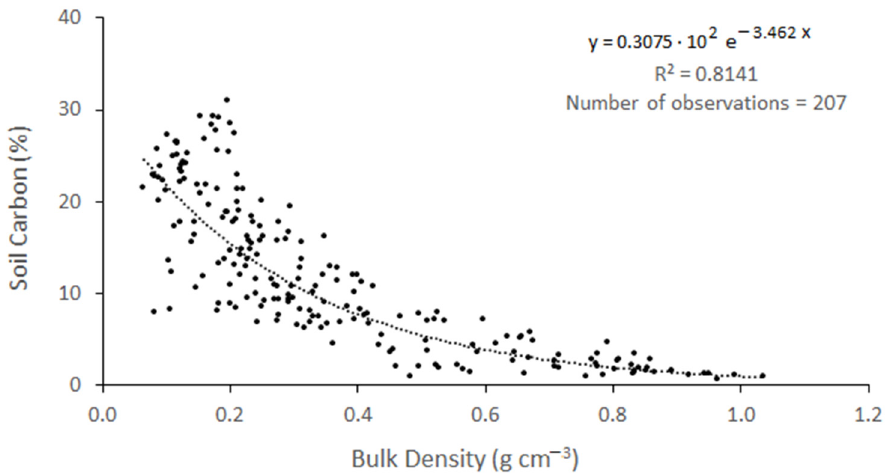
Figure 3. Relationship between bulk density (g cm − 3 ) and the soil organic carbon concentration (%) in the mangrove soil. Samples from all sampling sites and soil depth from 1 m upwards were used.